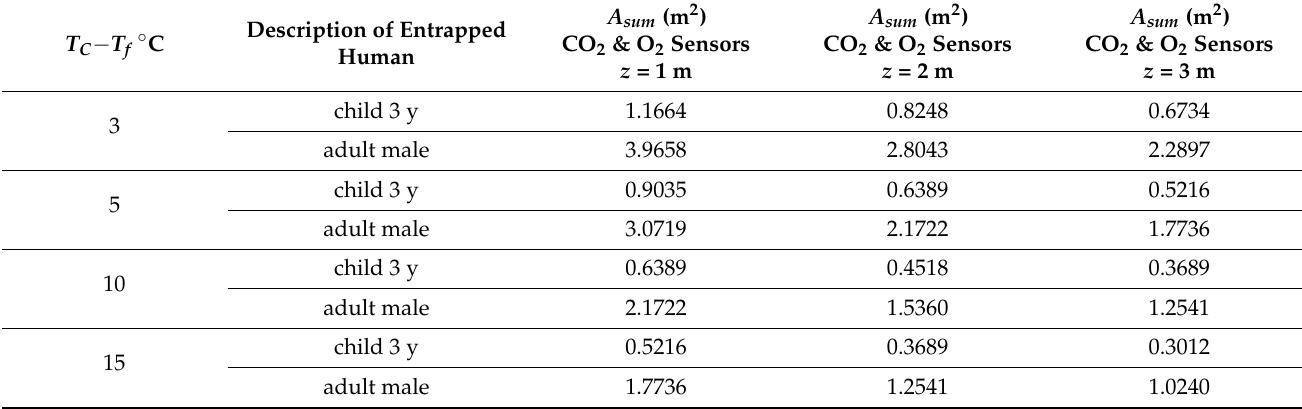
Table 7. Estimation of maximum total possible area of openings in voids (Stack